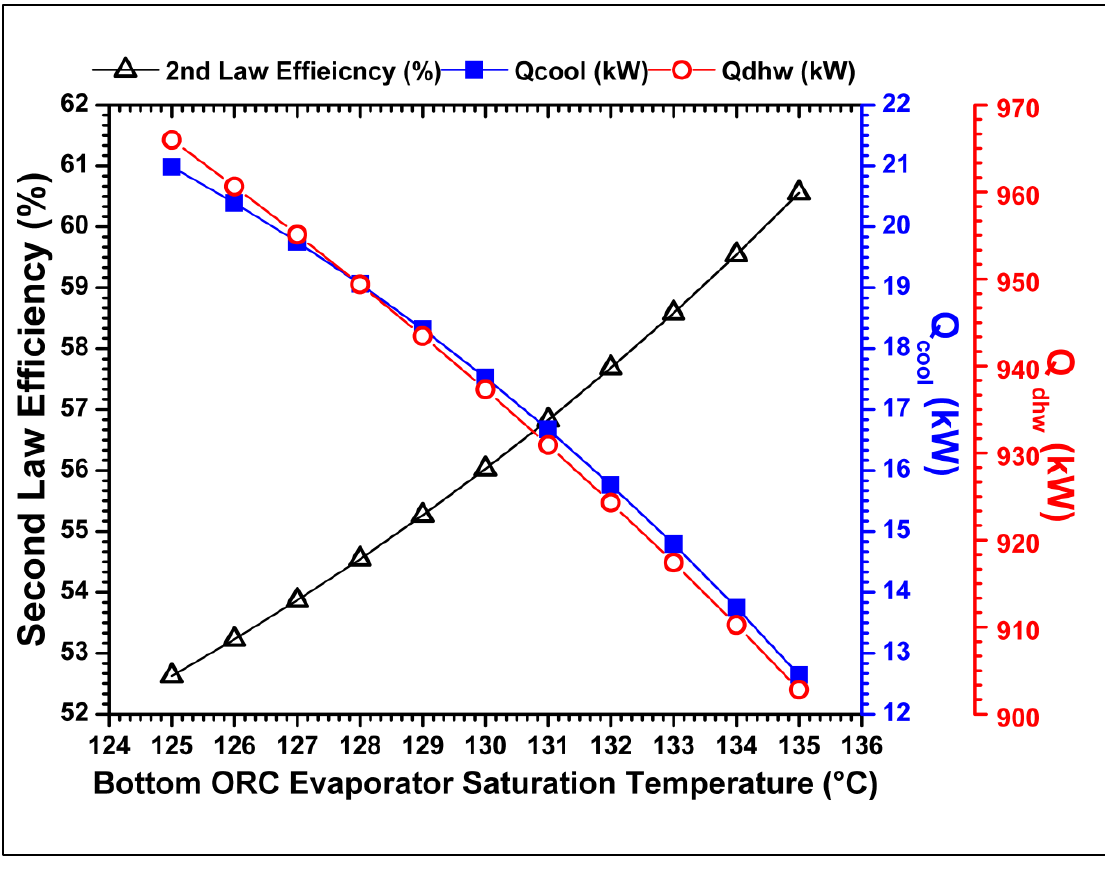
Figure 10. The variation of the cooling, heating, and second law efficiency against the saturation condensation temperature of the low temperature heat source powered ORC.